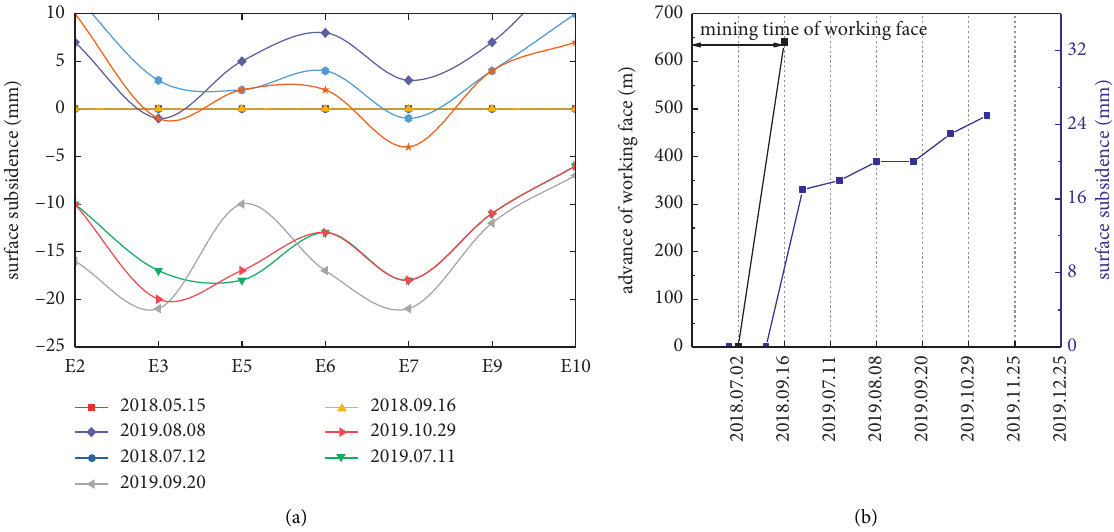
Figure 8: Surface subsidence values (a) at line E for each time period and (b) for each time period at measuring point E 3.